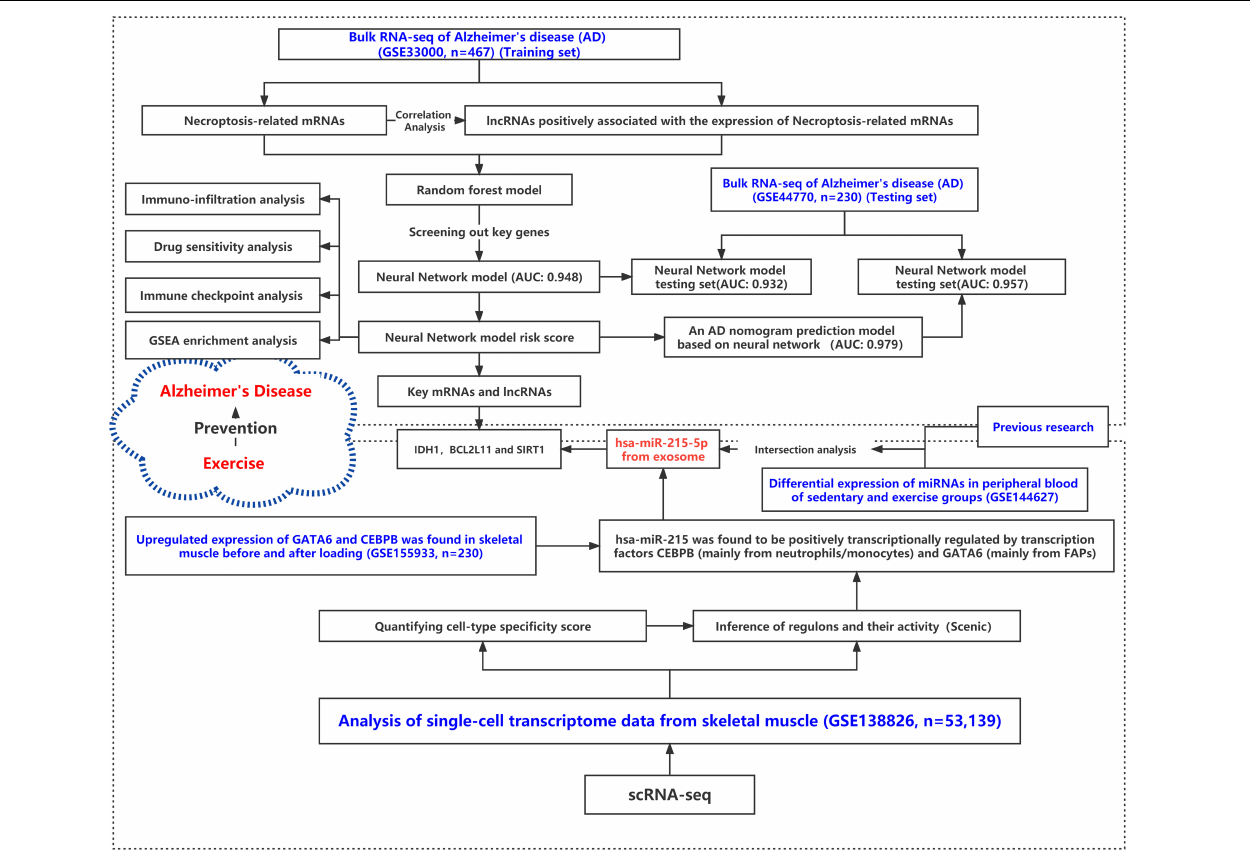
FIGURE 1 | Research roadmap for this